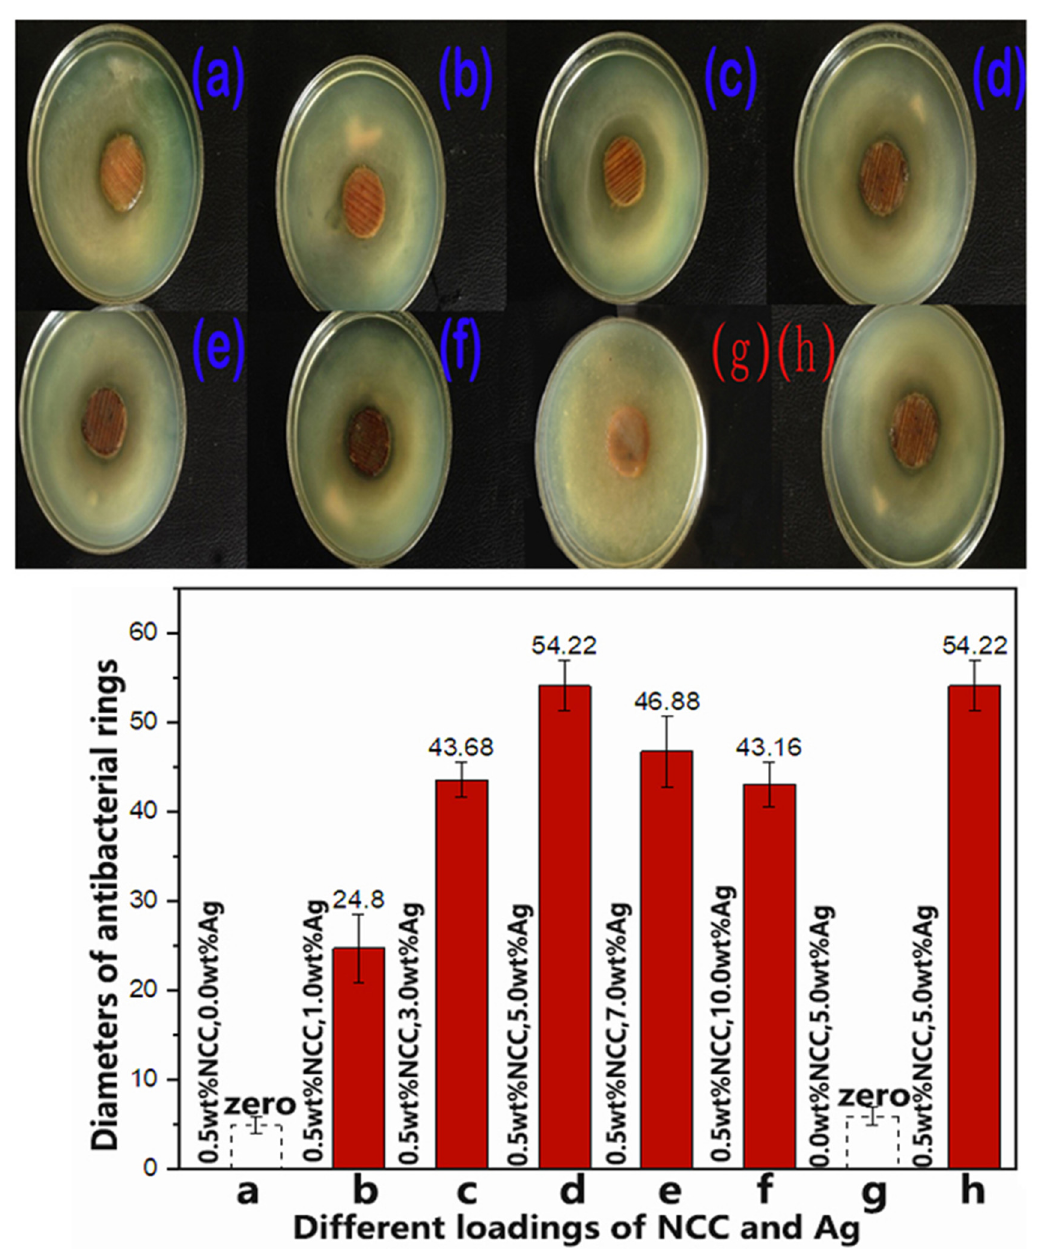
Figure 2. The results of antimicrobial experiment.